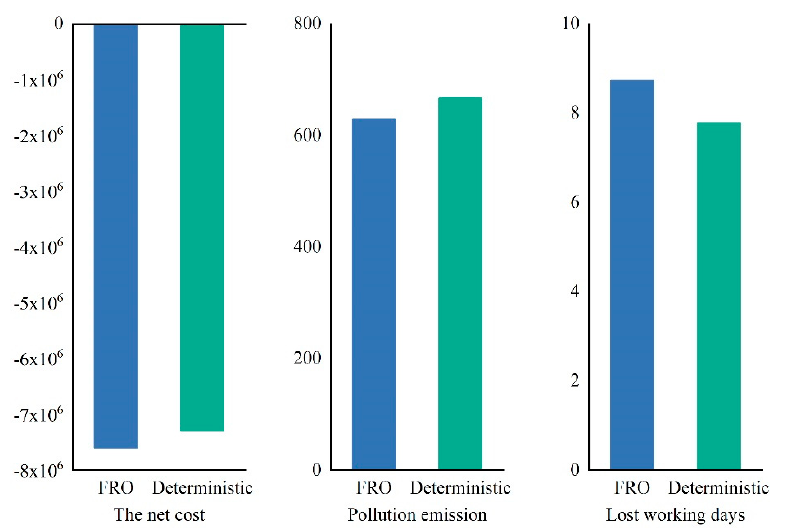
Figure 8. The comparisons of objective functions based on FRO and deterministic model with